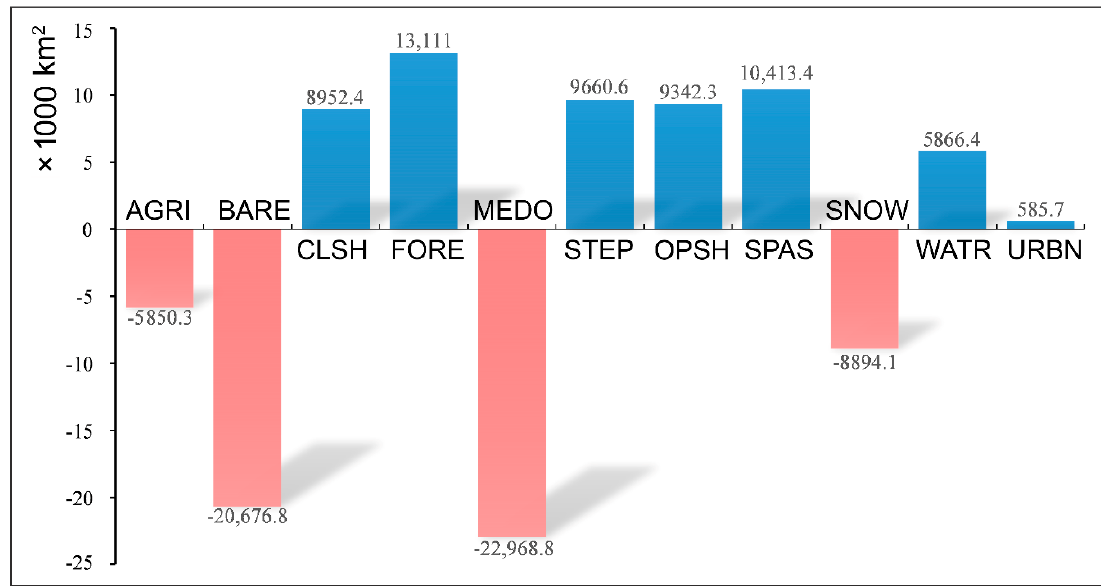
Figure 2. Land cover net gain and net loss in the Qinghai-Tibetan Plateau. FORE stands for all forest types; AGRI, agricultural land; BARE, bare ground; CLSH, closed shrubland; MEDO, meadow; OPSH, open shrubland; SNOW, permanent snow cover; STEP, steppe; SPAS, sparse vegetation; URBN, urban area; and WATR, water.